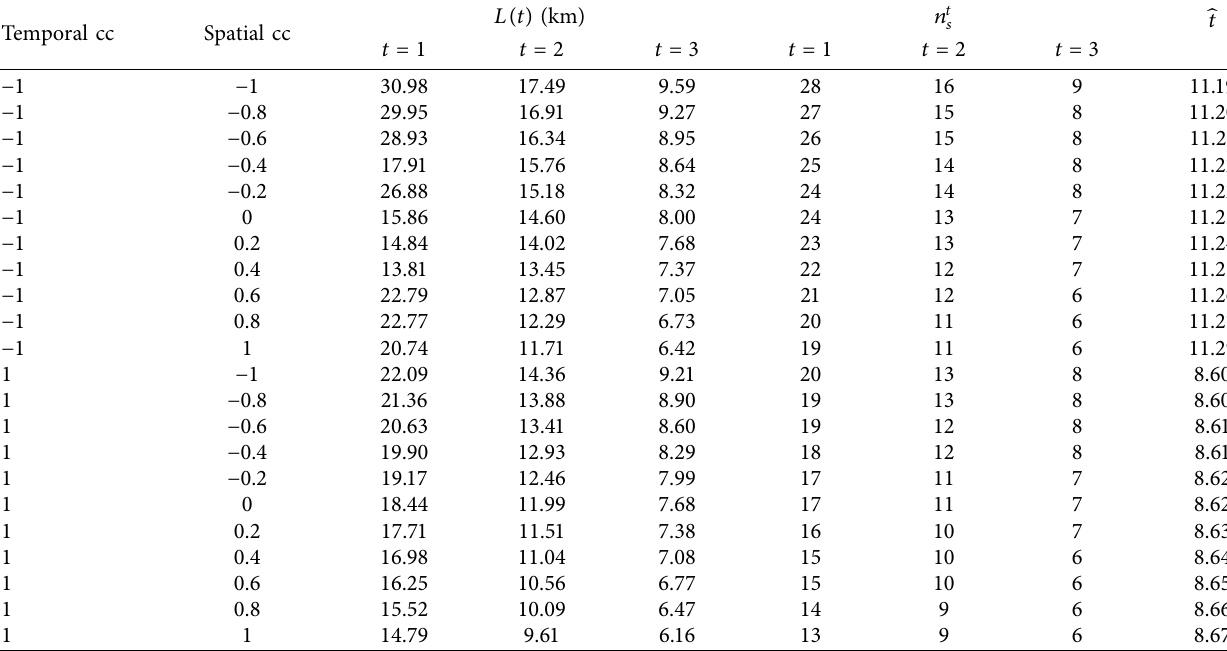
Table 2: Numerical results.